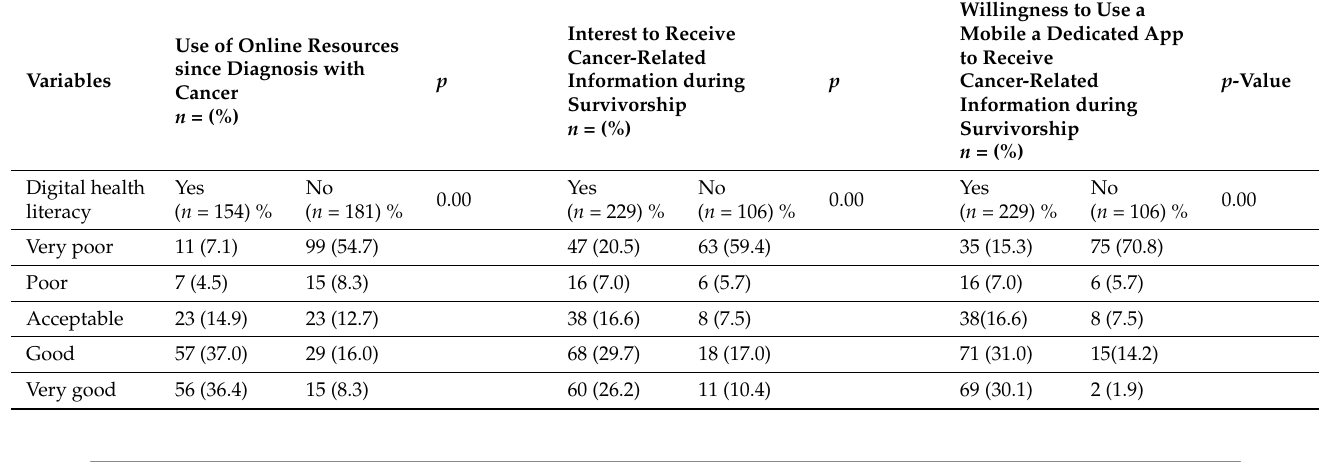
Table 5. Digital trends of breast cancer survivors and digital literacy ( n = 335).